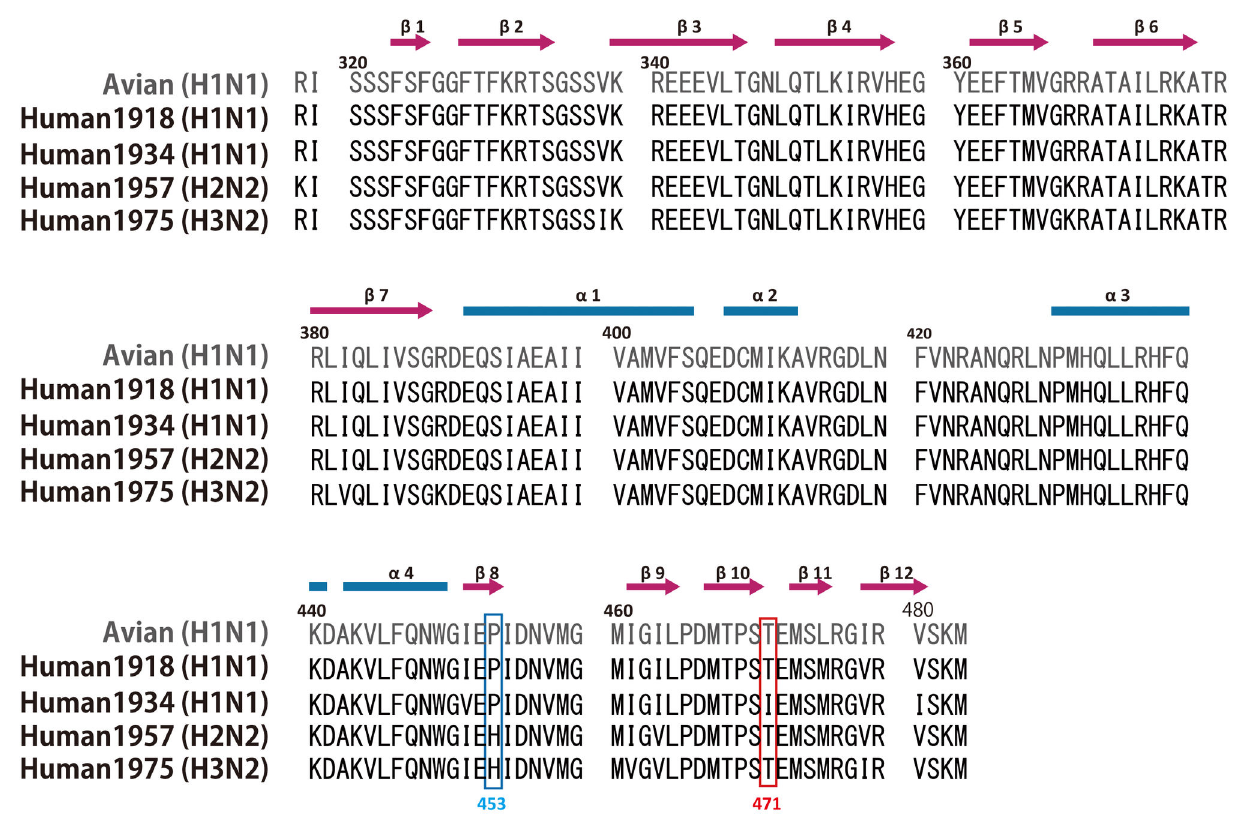
Figure 4. Sequence alignment of the PB2 middle domains. Avian strain is shown in grey (A/mallard/Tennessee/11464/1985 (H1N1)). Human influenza virus is shown in black: H1N1 (A/Brevig Mission/1/1918), H1N1 (A/Puerto Rico/8/1934), H2N2 (A/Albany/ 20/1957), and H3N2 (A/Victoria/3/1975) as 2VQZ. The blue and red boxes are the mutation sites at 453 and 471 (See details in the text). Twelve β-strands and four α-helices are depicted in hot pink arrows and light blue bar, respectively.